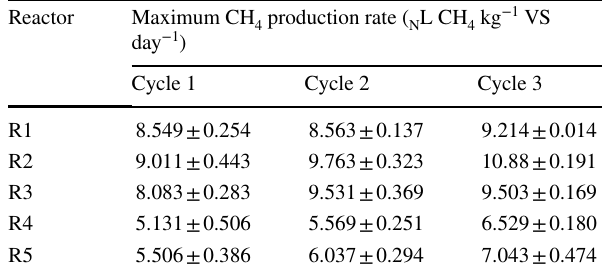
Table 4 Average of the CH 4 production rate during the